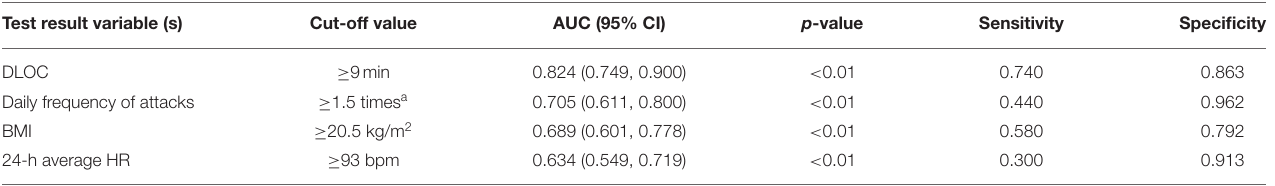
TABLE 3 | The cut-off value for diclassification the continuous variables in training set.